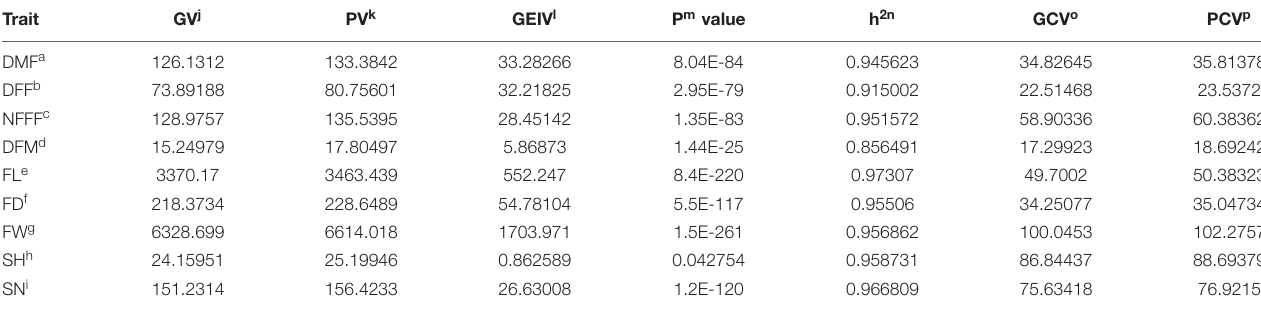
TABLE 2 | Estimates of variance components and heritability for nine traits.